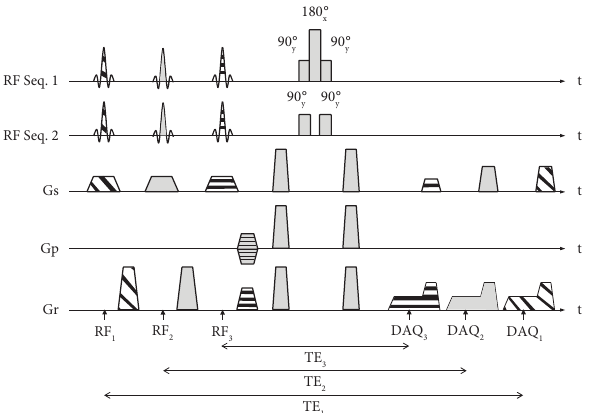
Figure 1: Multislice B 1 mapping method using RF pulses of 90 y for sequence 1 and 90 y ° − 0 x ° − 90 180 x ° − 90 y °